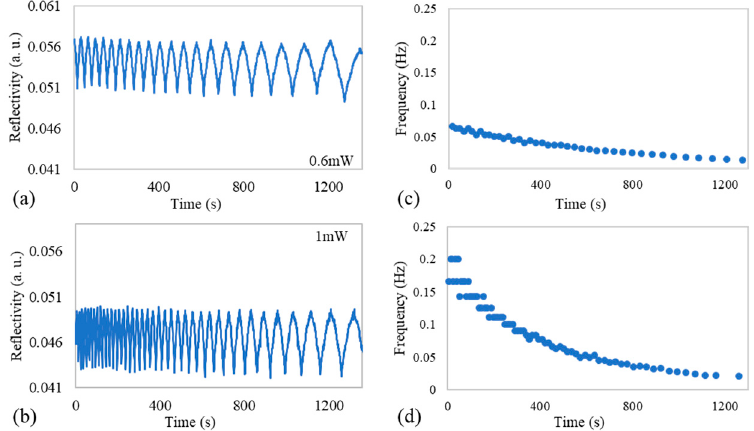
Figure 5. ( a , b ) Enlarged PATR results in region (I) of Figure 4b,c; ( c , d ) oscillation frequency in ( a , b ).